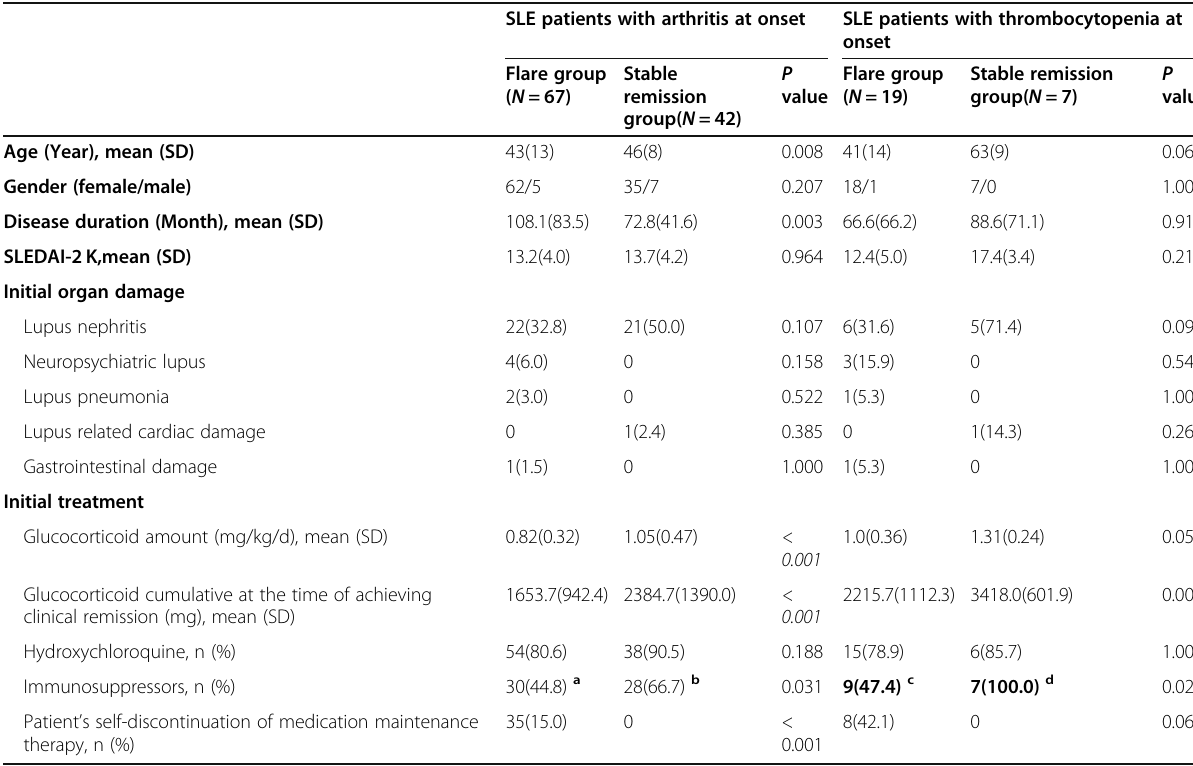
Table 3 Two subgroup analyses of patients with thrombocytopenia and arthritis at onset SLE patients with arthritis at onset SLE patients with thrombocytopenia at